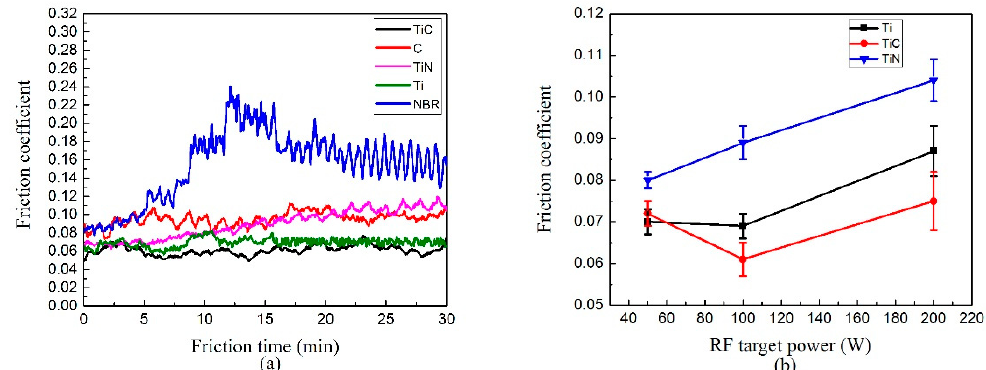
Figure 11. Friction coefficient (CoF) of (Ti:N)-GLC films under mixed lubrication: ( a ) friction coefficient curves of films at 100 W; ( b ) the mean steady-state friction coefficient vs. RF power.